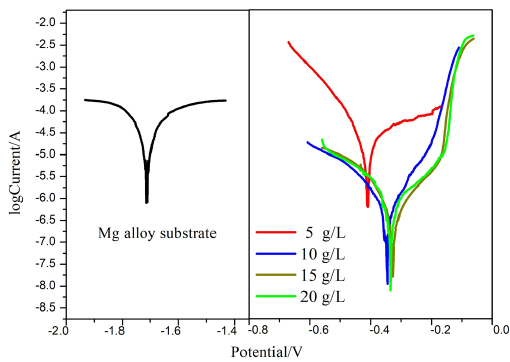
Figure 8. Polarization curves of magnesium alloy and Ni-W-P coatings with different Na WO concentrations in 3.5 wt.% NaCl solution. 2 4 Table 5. Fitting parameters for the polarization curves of magnesium alloy and Ni-W-P coatings in 3.5 wt.% NaCl solution.